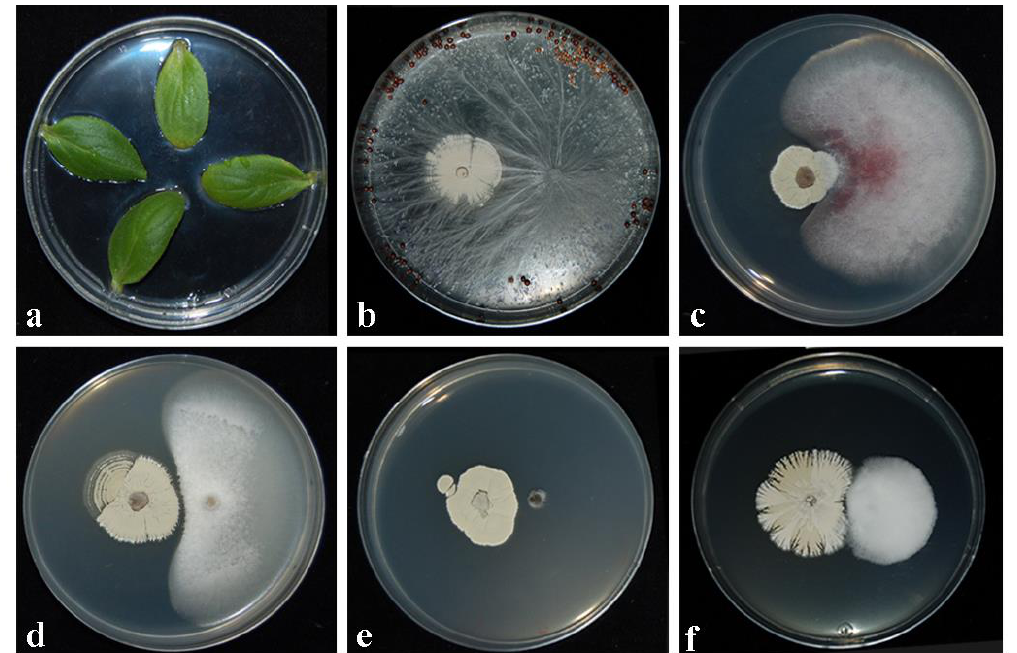
Figure 1. Phytotoxicity/pathogenicity assays carried out on young leaf cotyledones of cucumber ( a ), and inhibition activity played by CARA17 strain against Athelia rolfsii ( b ), Fusarium oxysporum ( c ), Plectosphaerella ramiseptata ( d ), Sclerotinia sclerotiorum ( e ), and Verticillium dahliae ( f ) after 28 days of exposition of fungal pathogens vs. CARA17 strain grown on medium.